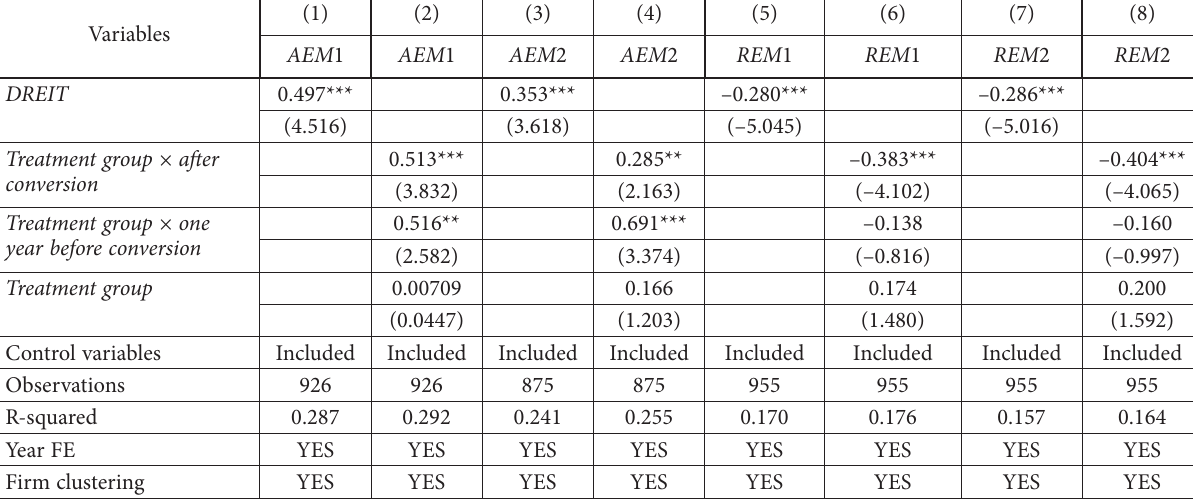
Table 10. Panel B Test on entropy-balanced